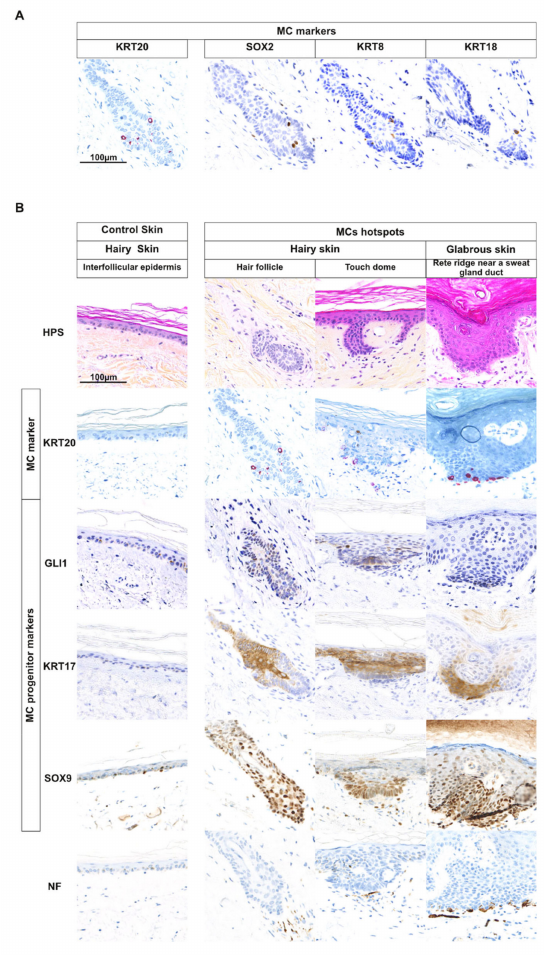
Figure 1. Merkel cells and possible Merkel cell progenitors in human skin. ( A ) Keratin 20 (KRT20), SRY-box transcription factor 2 (SOX2), KRT8, and KRT18 staining was used to identify Merkel cells (MCs) (bar = 100 µ m) (only one hotspot investigated for illustration purpose). Merged analysis is available in Figure S1B. ( B ) Identification of potential MC progenitors in human skin: Three MC hotspots as well as interfollicular epidermis for comparison are depicted (bar = 100 µ m) (15 hotspots investigated in total). Immunohistochemical staining revealed expression of KRT17 and SOX9 in the epidermal cells surrounding di ff erentiated MCs suggesting that these cells are MC progenitors. Nuclear GLI family zinc finger 1 (GLI1) was detected only close to MC hotspots in hairy, but not in acral skin. Of note, neurofilament (NF)-expressing dermal nerves were observed in contact with the